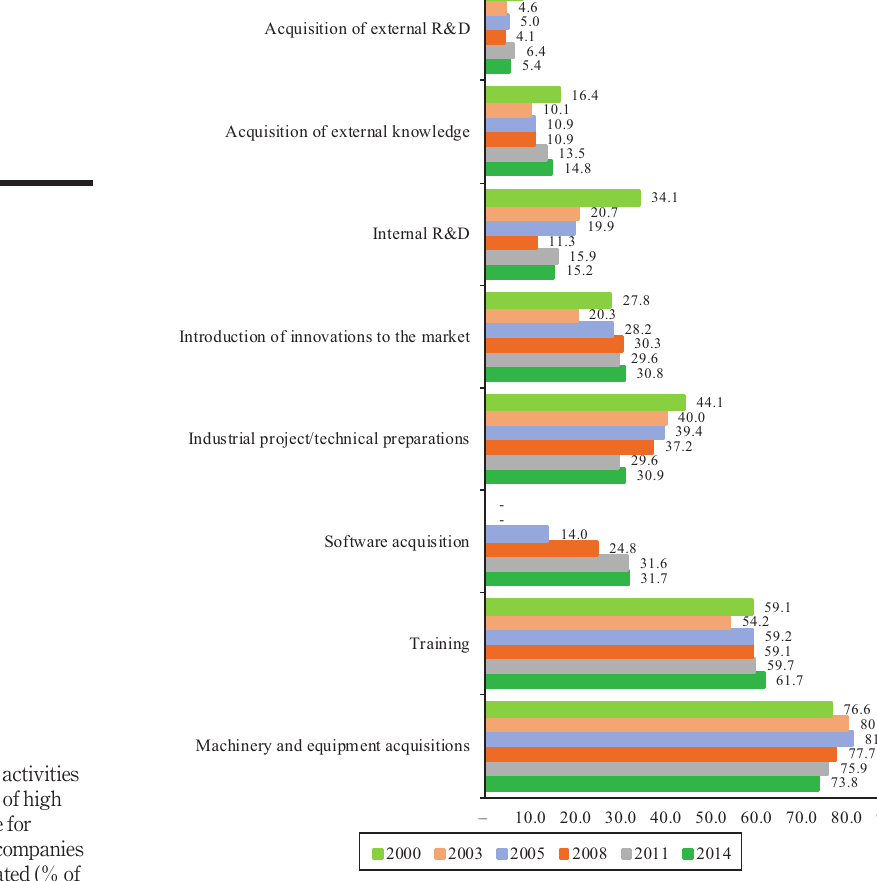
Figure 3. Innovative activities considered of high importance for industrial companies that innovated (% of responses) –